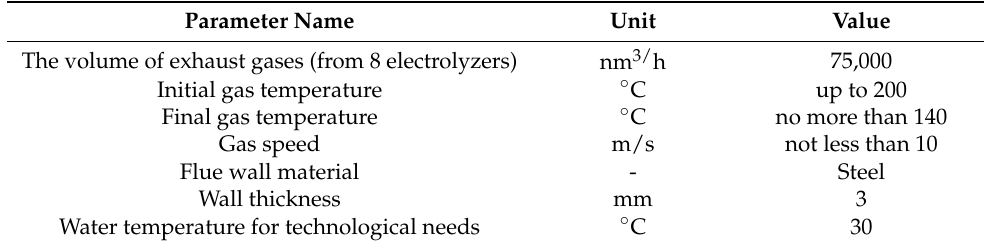
Table 2. Operating parameters of the cleaning gas ducts of the RA-500